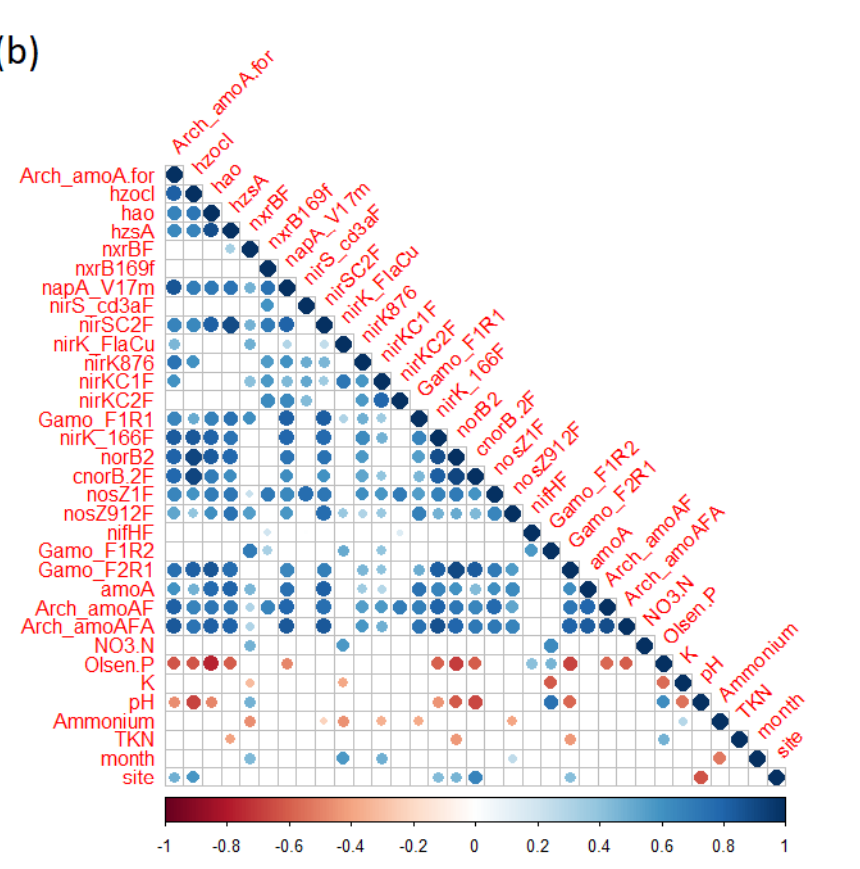
Figure 2. Interrelationships of genes of the nitrogen cycle. ( a ) Average transcript levels of the 25 genes are indicated by thickness of arrows connecting intermediates. The processes and corresponding genes were nitrate reduction [ napA ], denitrification [ nirK , cnorB , and nosZ ], nitrification [ Gamo , hao , and nxrB ], anammox [ hzsA and hzocl ], and nitrogen fixation [ nifH ]. No reactions were included for assimilatory nitrate reduction, and the result for DNRA [ nrfA ] for nitrite to ammonia conversion was invalid because R 2 value was <0.95 for the standard curve. ( b ) Correlations between the 25 gene transcripts and chemical soil properties derived by Spearman correlation showing only significant correlations ( p <